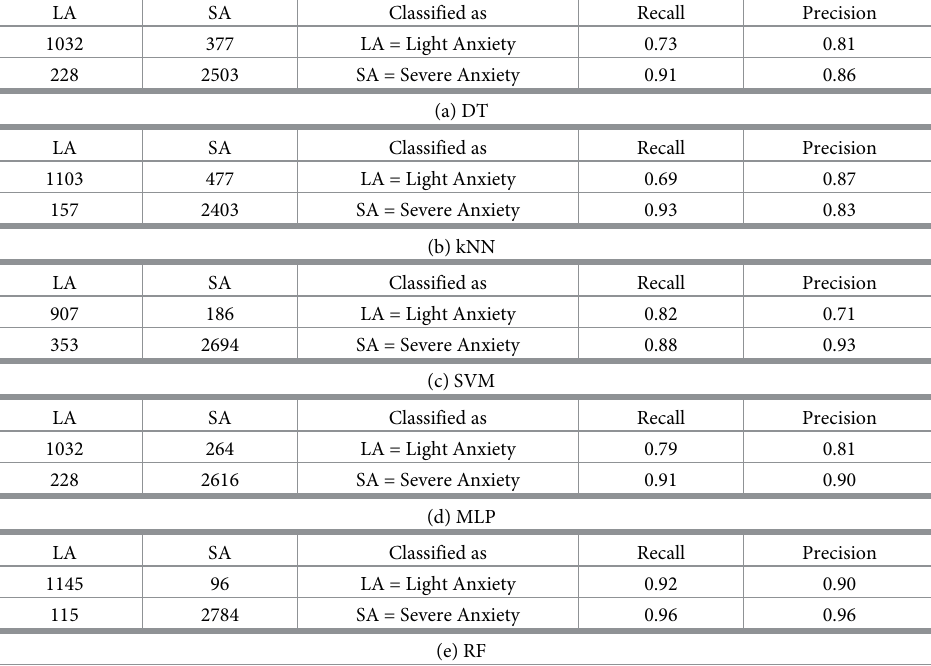
Table 3. Confusion matrix for two level anxiety classification for DT, kNN, SVM, MLP and RF classifier using HAM-A based